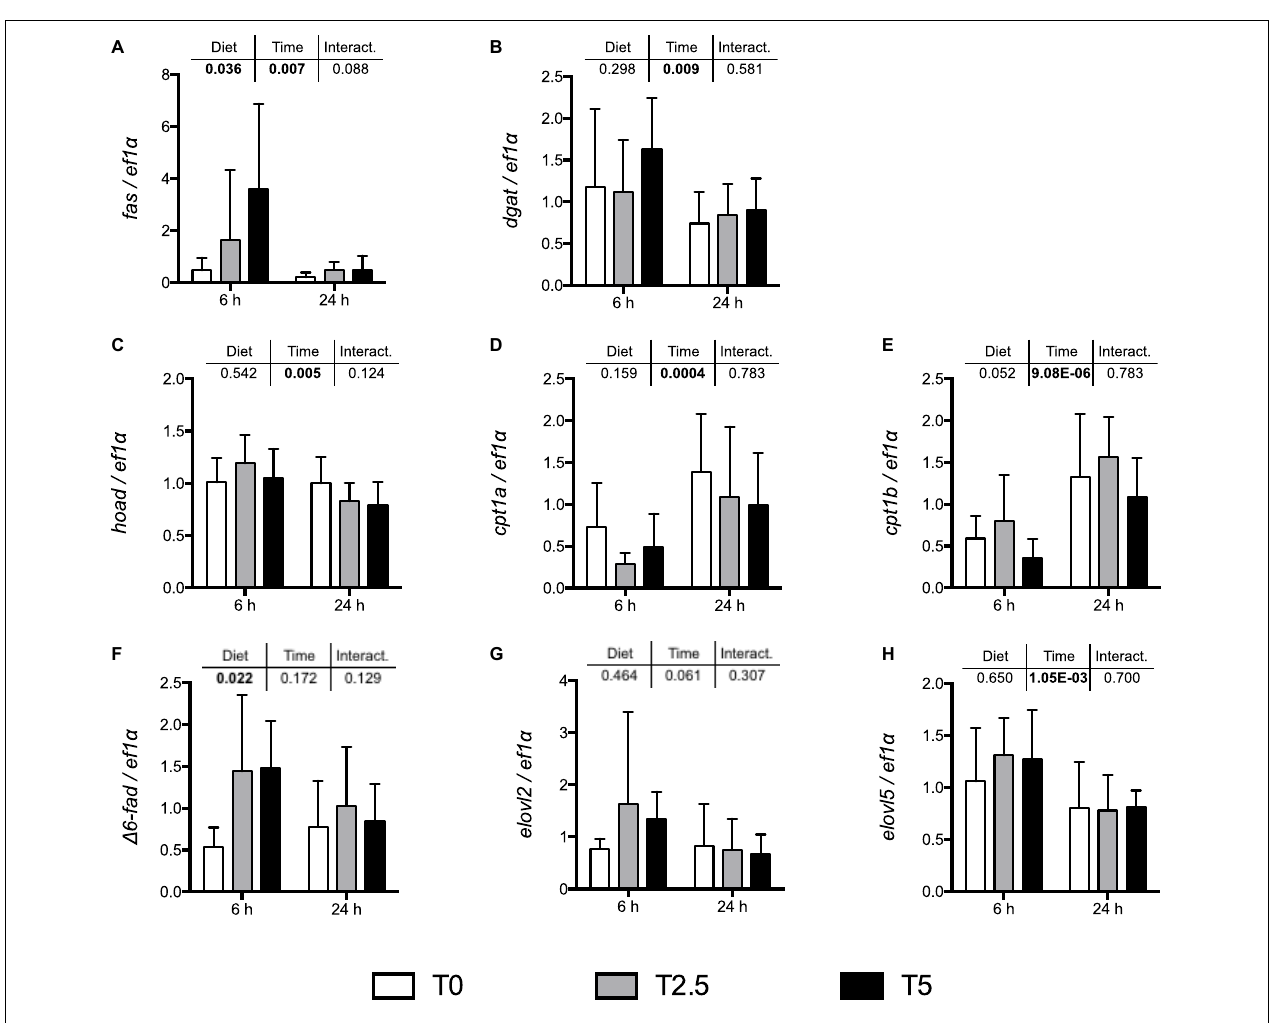
FIGURE 1 | mRNA levels of selected lipogenic enzymes (A) fas (fatty acid synthase), (B) dgat (diglyceride acyltransferase); lipolytic enzymes (C) hoad (3-hydroxyacyl-CoA dehydrogenase), (D) cpt1a and (E) cpt1b (carnitine palmitoyltransferase I a and b, respectively); and enzymes involved in long chain PUFA biosynthesis: (F) (cid:49) 6-fad (acyl-CoA 6-desaturase), (G) elovl2 and (H) elovl5 (elongation of very long-chain fatty acid protein 2 and 5, respectively), in the liver of rainbow trout ( Oncorhynchus mykiss ) fed with different levels of glycerol (0, 2.5, and 5%) for 8 weeks. Values are mean ± SD ( n = 8); nd: not detected. Significant differences were evaluated by two-way ANOVA ( p < 0.05, values in